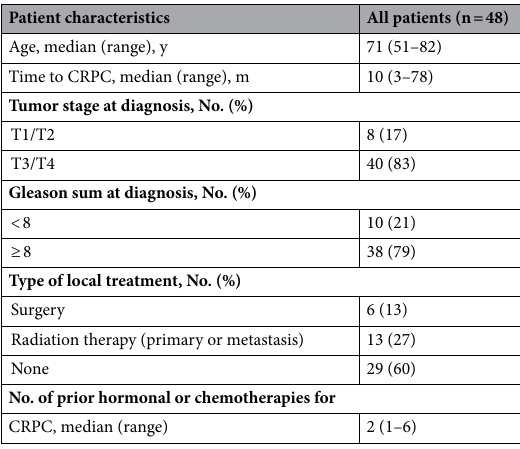
Table 1. Patient characteristics at the time of prostate cancer diagnosis and mCRPC . mCRPC, metastatic castration-resistant prostate cancer; m, months; no, number; PSA, prostate specific antigen; y,